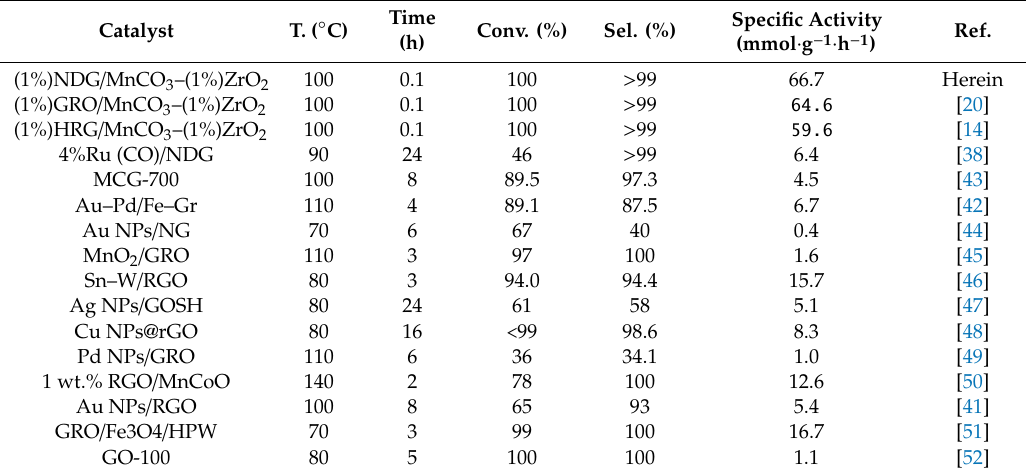
Figure 11. Recyclability results of (1%)NDG/MnCO 3 –(1%)ZrO 2 catalyst for PhCH 2 OH oxidation. Conditions: 2 mmol PhCH 2 OH, 15 mL toluene, O 2 20 mL/min, 0.3 g catalyst, 100 °C and 6 min. Table 3. Comparative results of the PhCH 2 OH oxidation catalyzed by various graphene containing